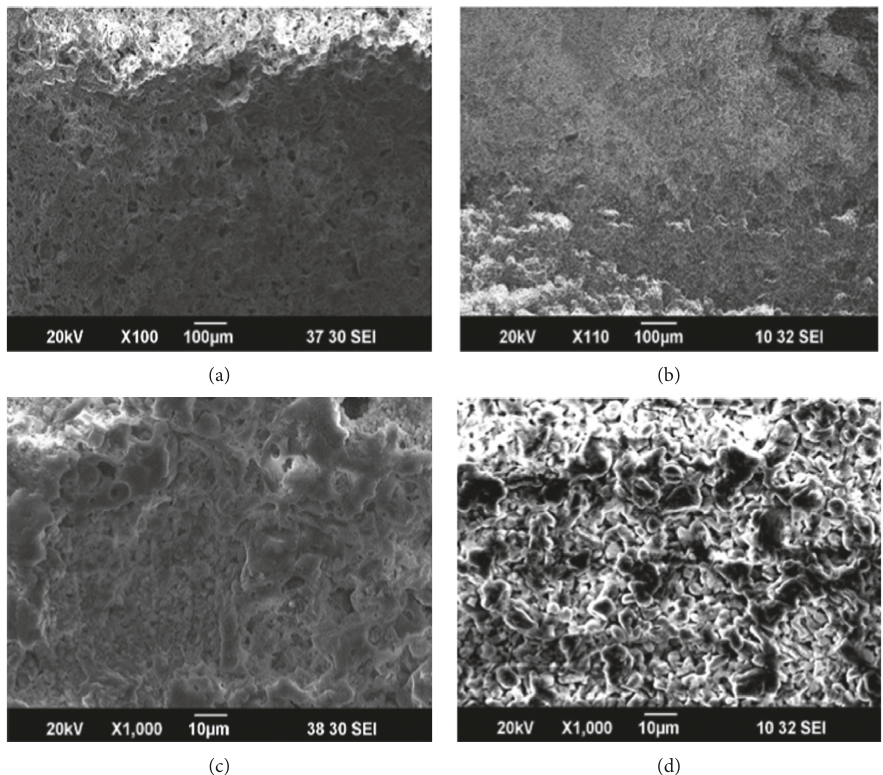
Figure 2: SEM pictures of the cross section of ceramic membranes: (a) α -Al ceramic membrane (size scale: 100 μ m); (c) α -Al 2 O 3 microceramic membrane (size scale: 10 μ m); (d) coal ash ceramic membrane (size scale: 10 μ